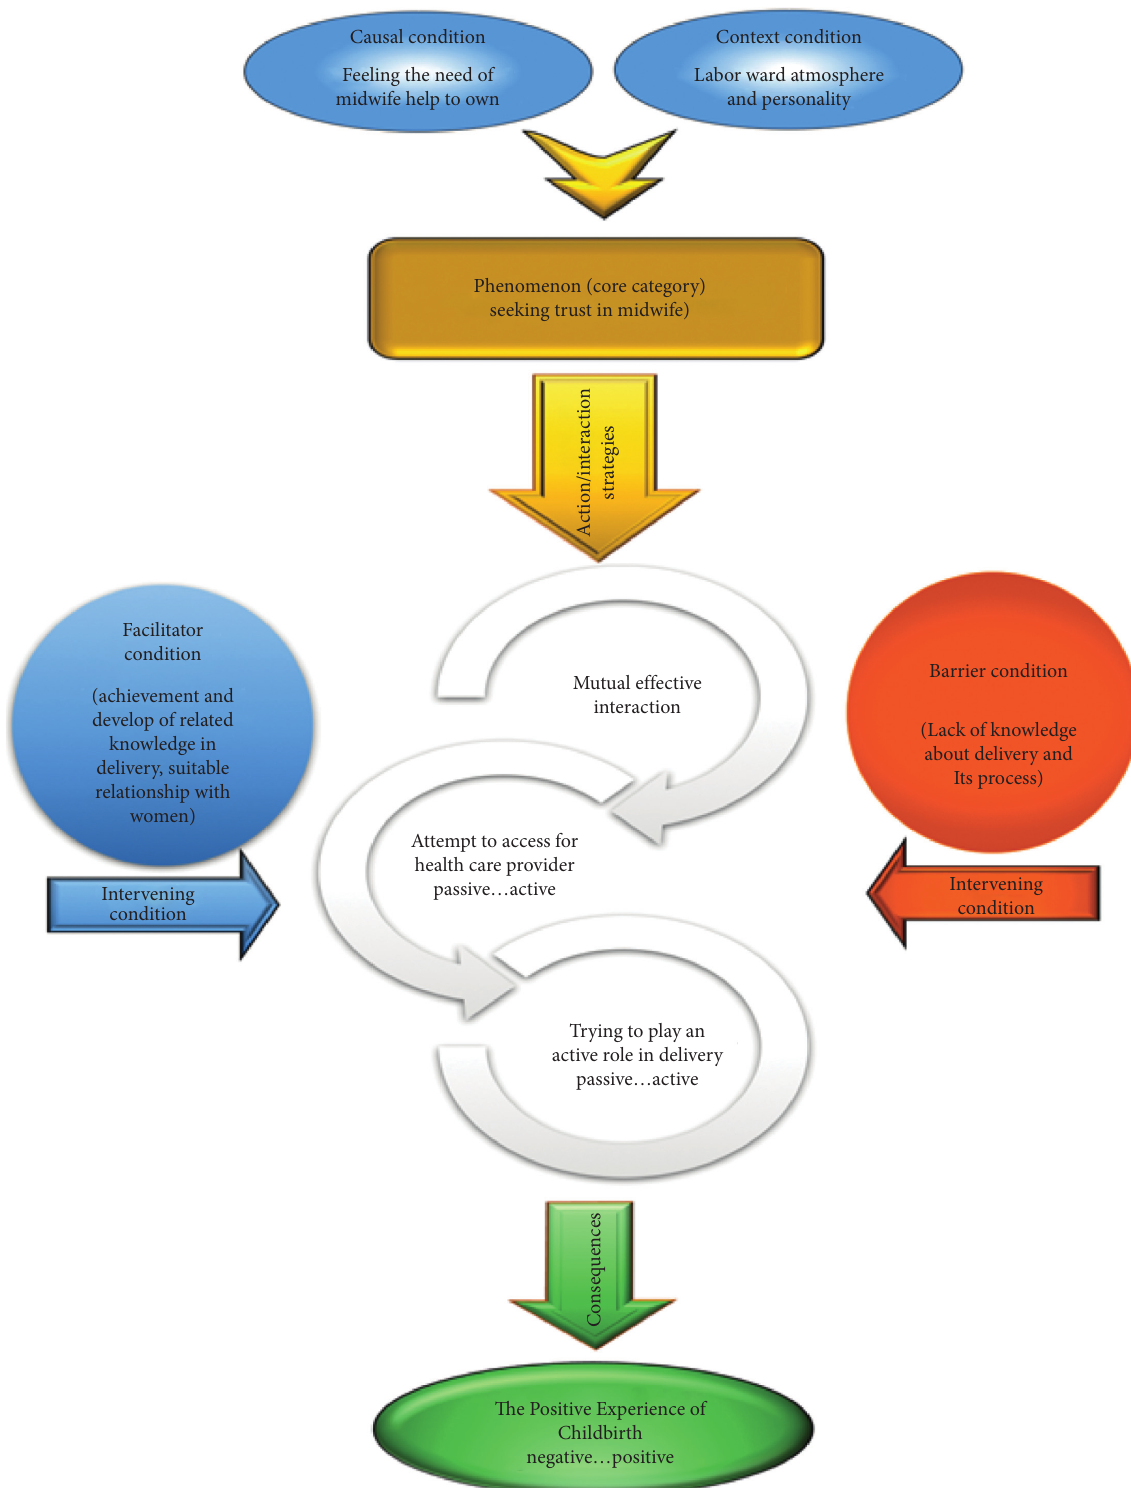
Figure 1: Theoretical scheme of trust in